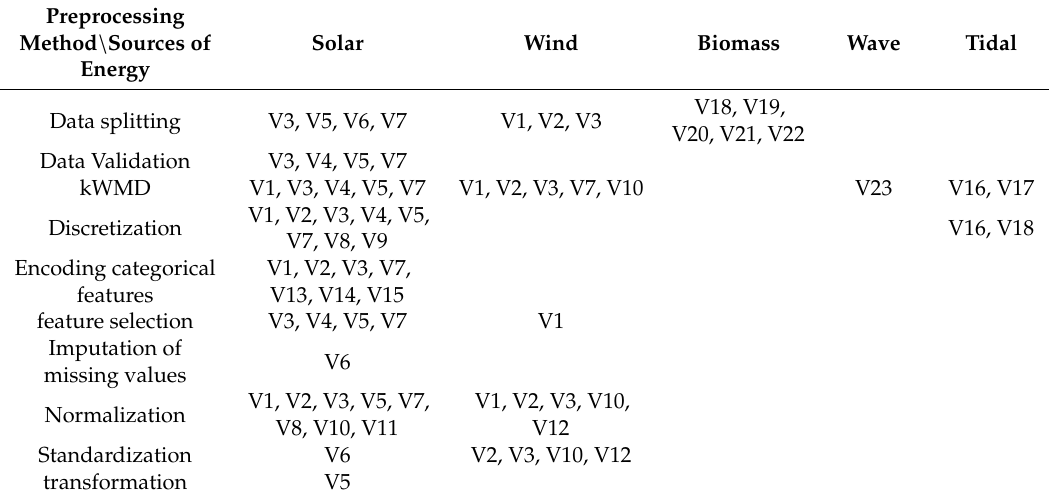
Table 5. Pre-processing techniques used by machine-learning models in renewable-energy predictions with di ff erent